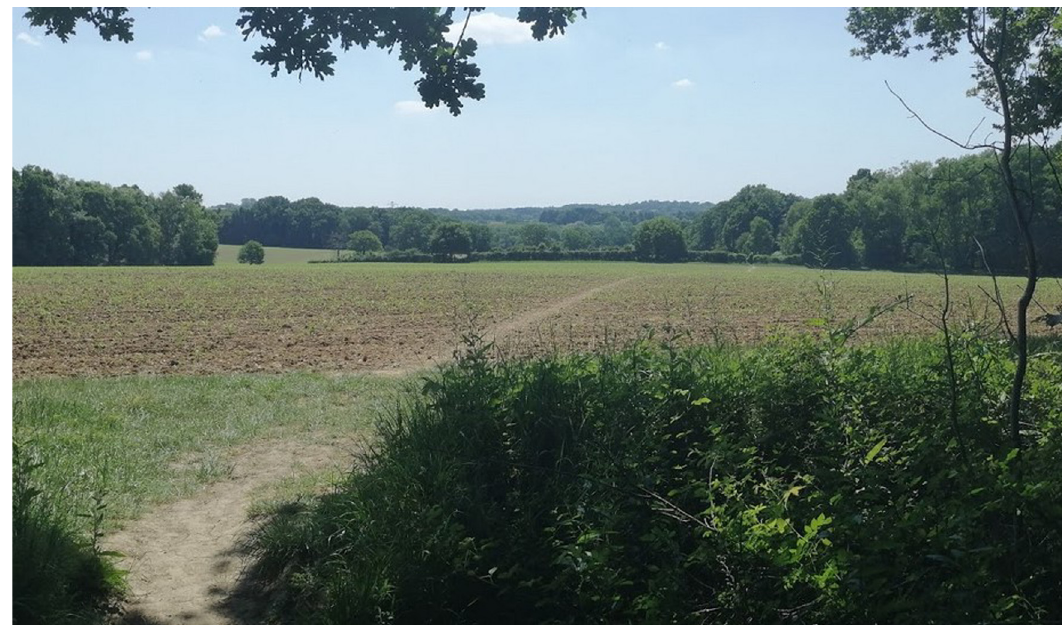
Figure 1: A line made by walking in